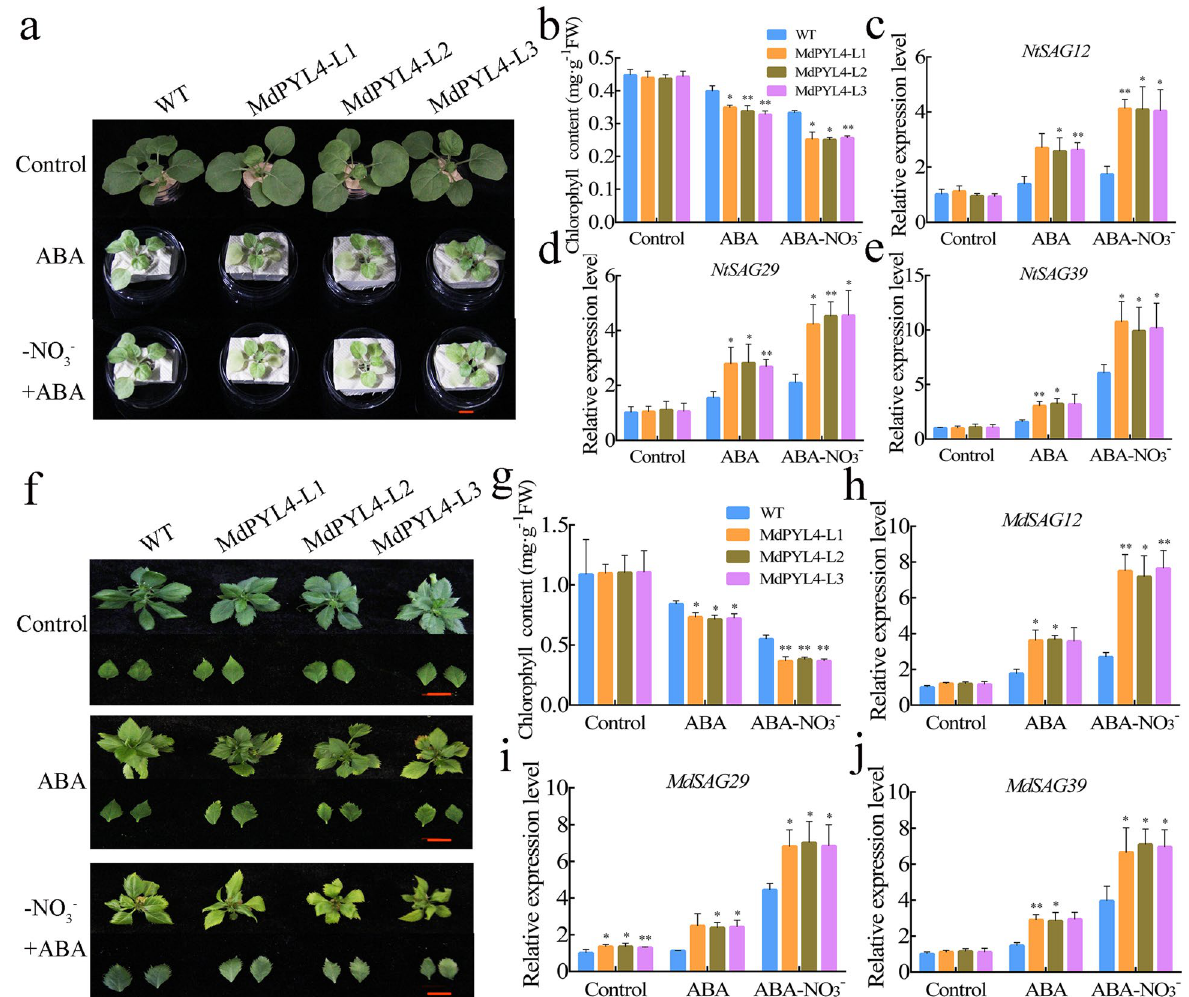
Fig. 9 Overexpression of MdPYL4 promotes ABA-induced leaf senescence under N deficiency